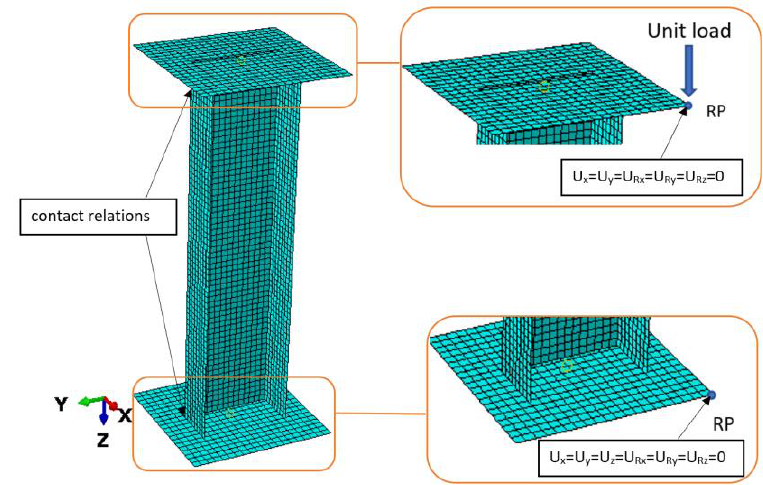
Figure 6. Boundary conditions of tested profile.